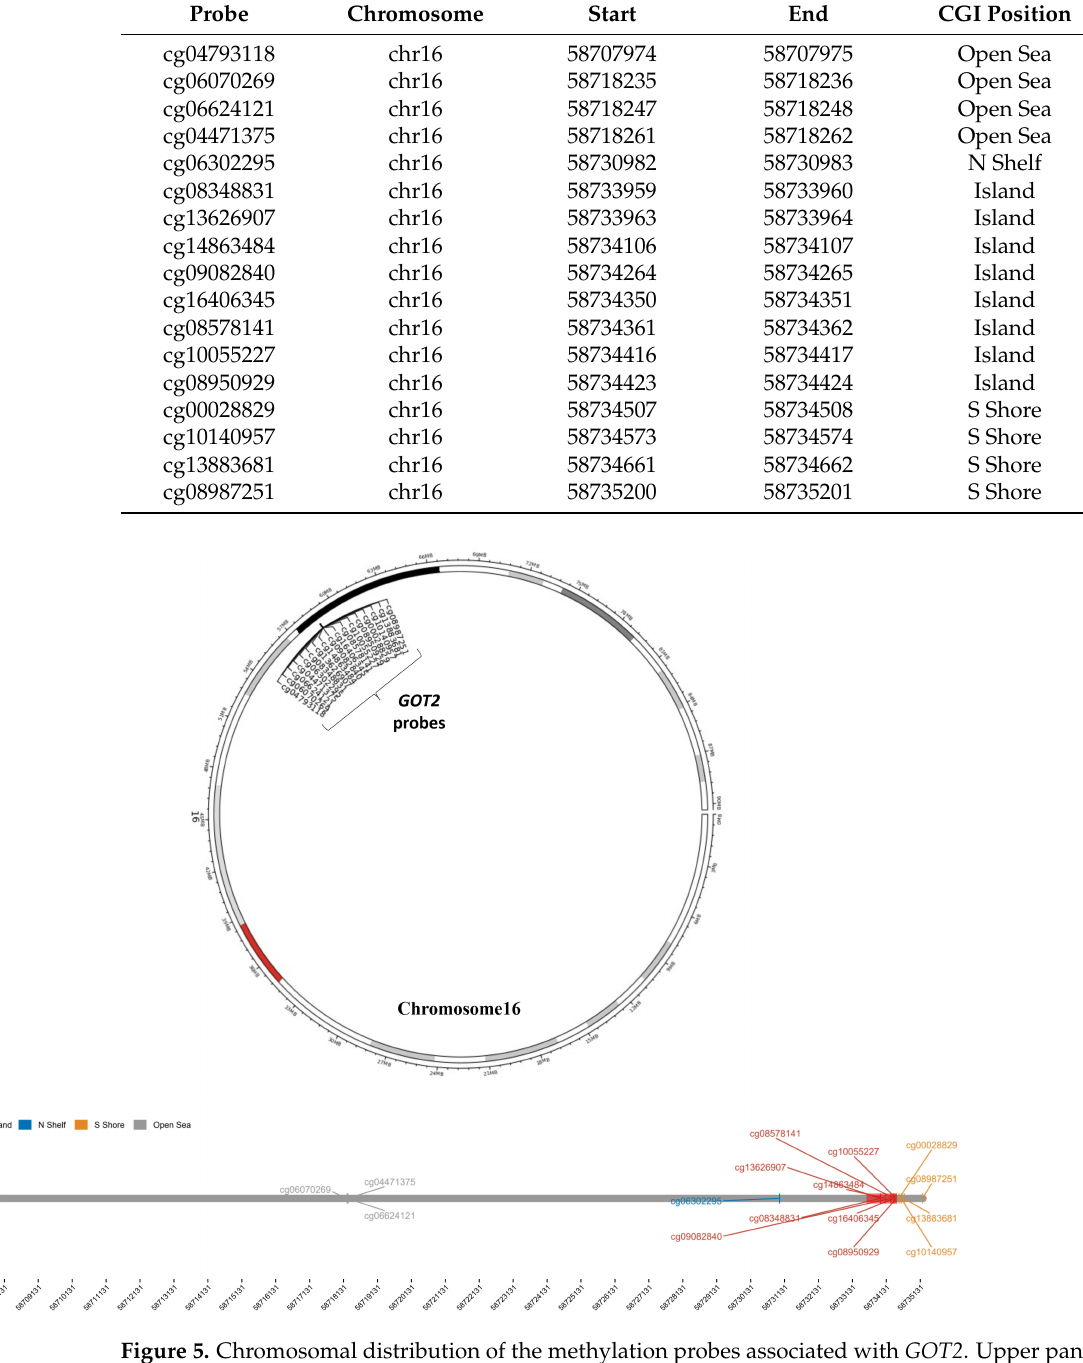
Figure 5. Chromosomal distribution of the methylation probes associated with GOT2 . Upper panel: Circos plot depicting the genomic information of GOT2 (16q21) and the probes used in this study. Lower panel: Segment plot showing the detailed information of genomic locations of each probe of GOT2 , highlighting CpG island, N shelf, S Shore and Open Sea. The coverage of the promoter region is displayed as the red region (red box), which includes eight probes (cg08348831, cg13626907, cg14863484, cg09082840, cg16406345, cg08578141, cg10055227 and cg08950929). Numbers below represent the genomic length scale (1